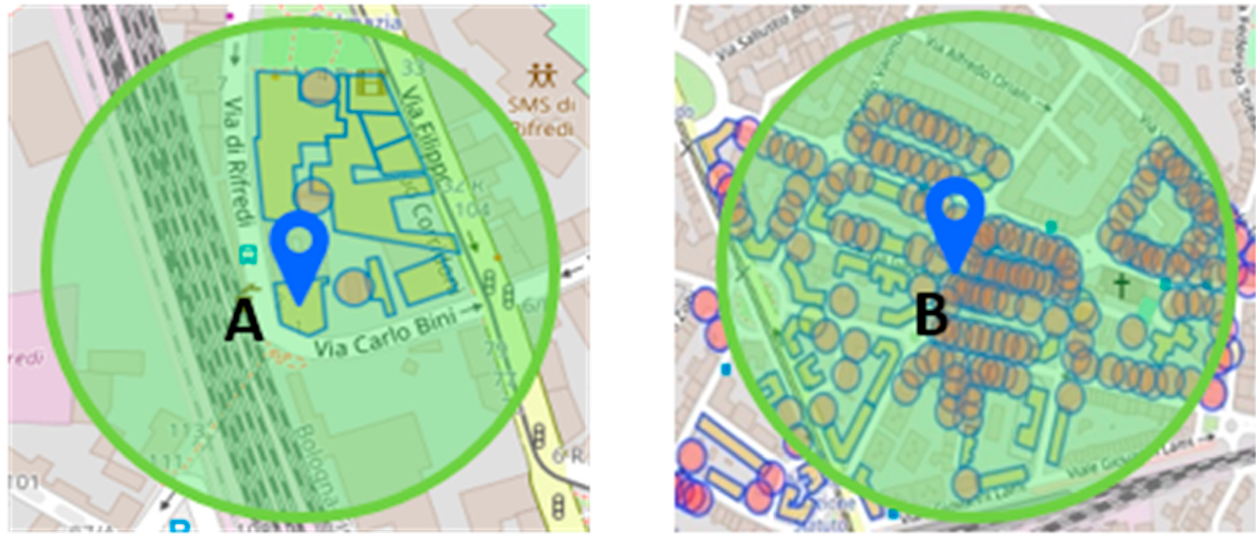
Figure 6. Density of residential buildings around stops 𝐀 and 𝐁 .